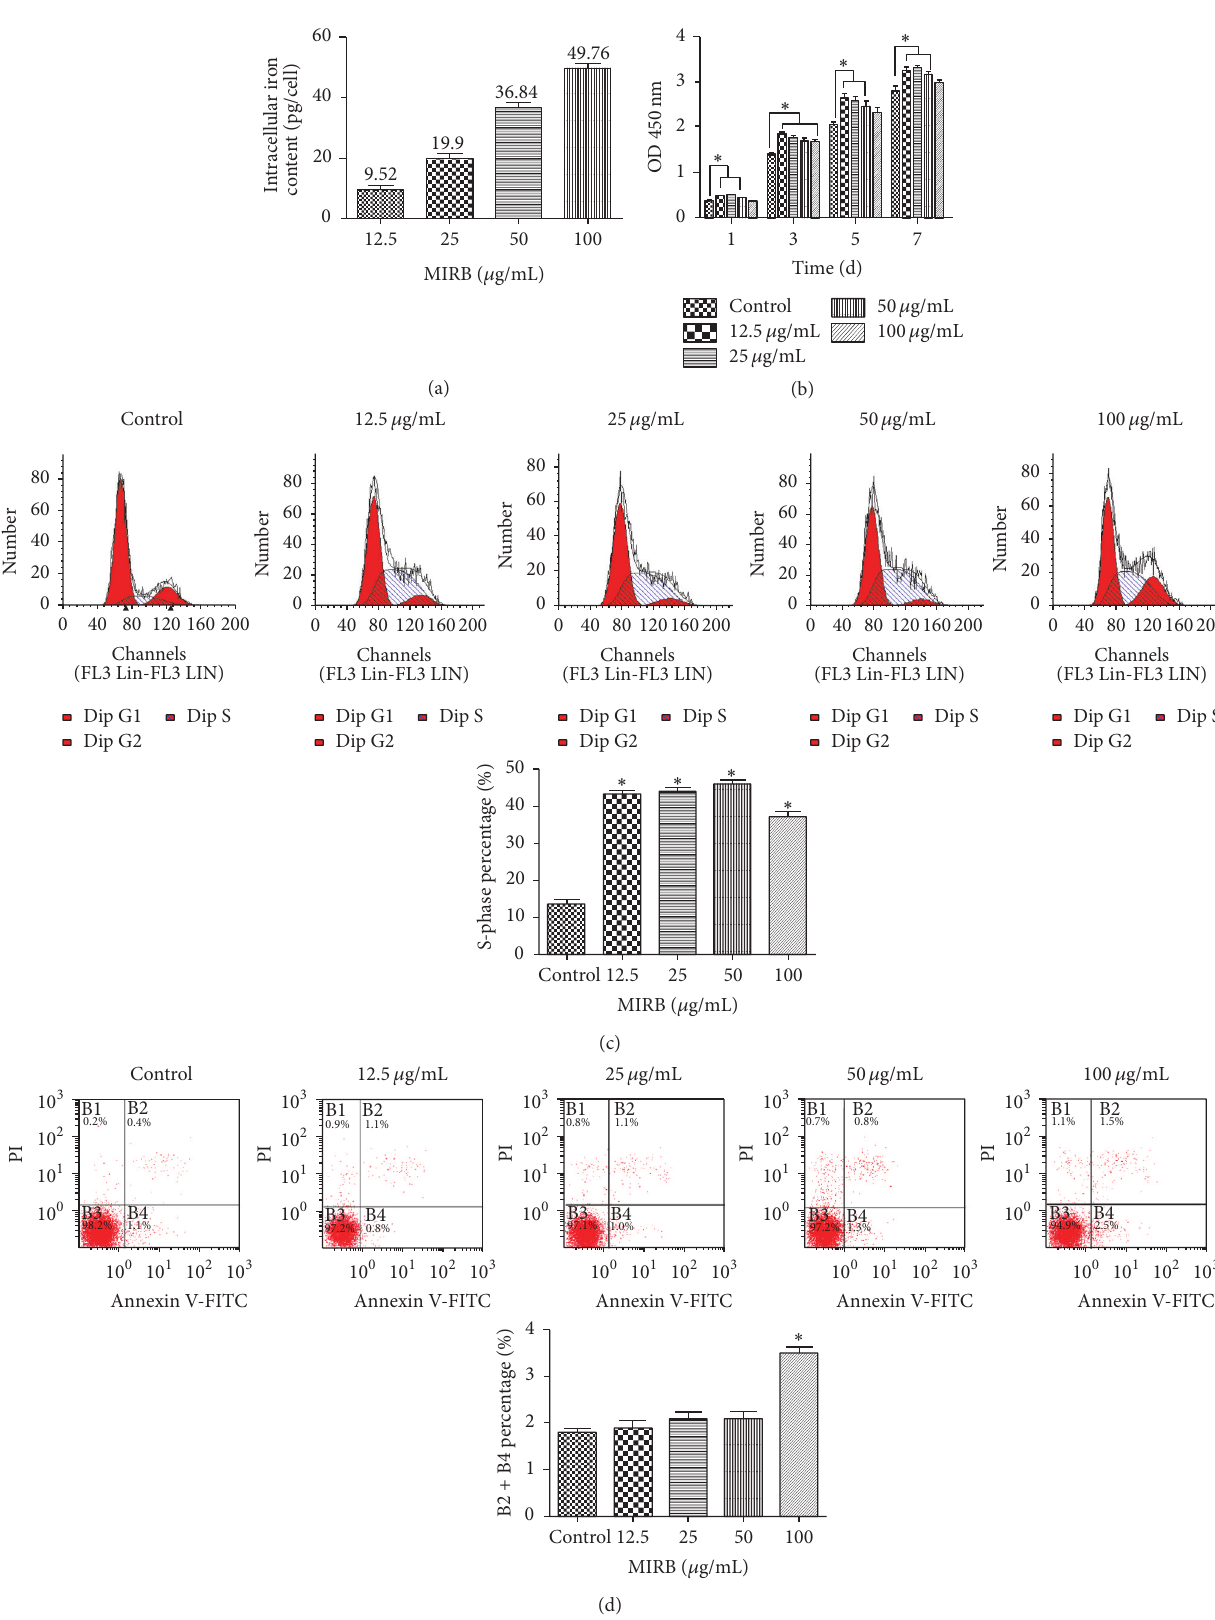
Figure 4: Biological effects of MIRB on hDPSCs. (a) Intracellular iron content analysis. (b) Proliferation capacity of hDPSCs measured with MTT assay. MIRB (12.5 𝜇 g/mL–50 𝜇 g/mL) promotes hDPSCs proliferation. ∗ 𝑃 < 0.05 . (c) Promotion effect of MIRB (12.5 𝜇 g/mL–100 𝜇 g/mL) on cell cycle progression. ∗ 𝑃 < 0.05 . (d) Effect of MIRB labeling on cell apoptosis. 100 𝜇 g/mL MIRB is toxic to hDPSCs. ∗ 𝑃 < 0.05